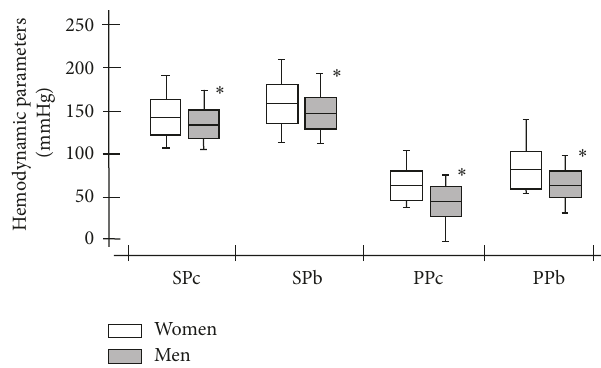
Figure 1: Comparison of systolic blood pressure and pulse pressure (both central and brachial) between the women and men. SPc = central systolic blood pressure; SPb = brachial systolic blood pressure;PPc=centralpulsepressure;PPb=brachialpulsepressure. ∗ Comparison of blood pressure parameters between all of the women and men ( 𝑃 < 0.05